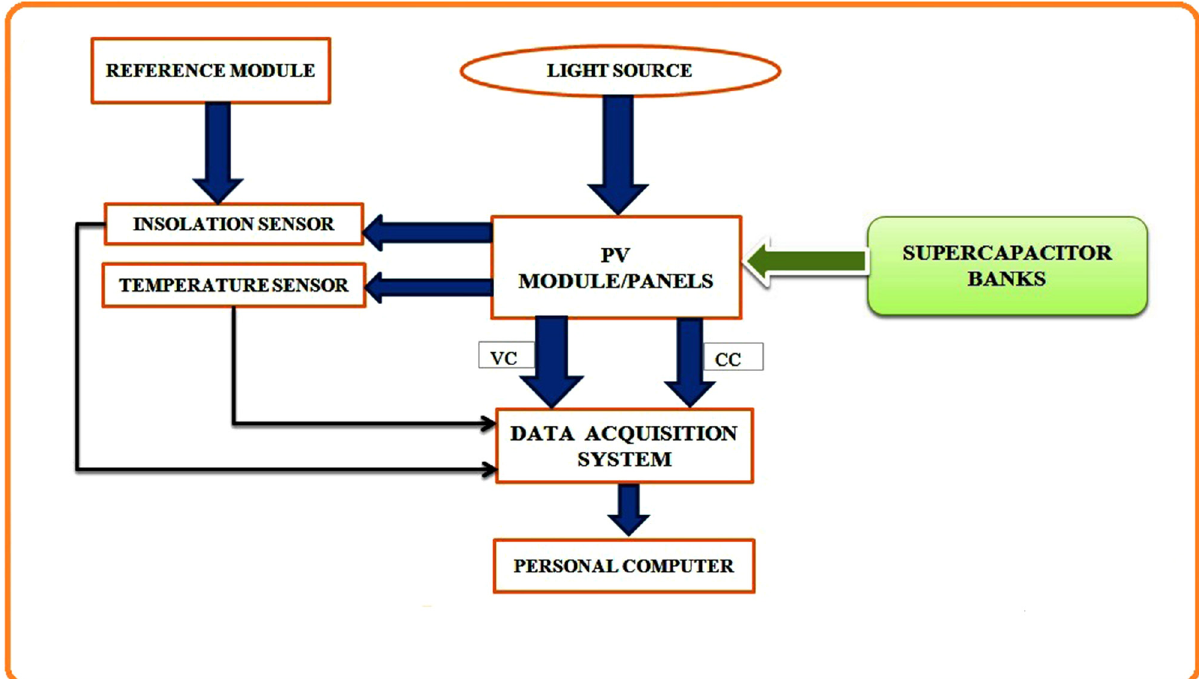
Fig. 2. Functional blocks of the testing setup.